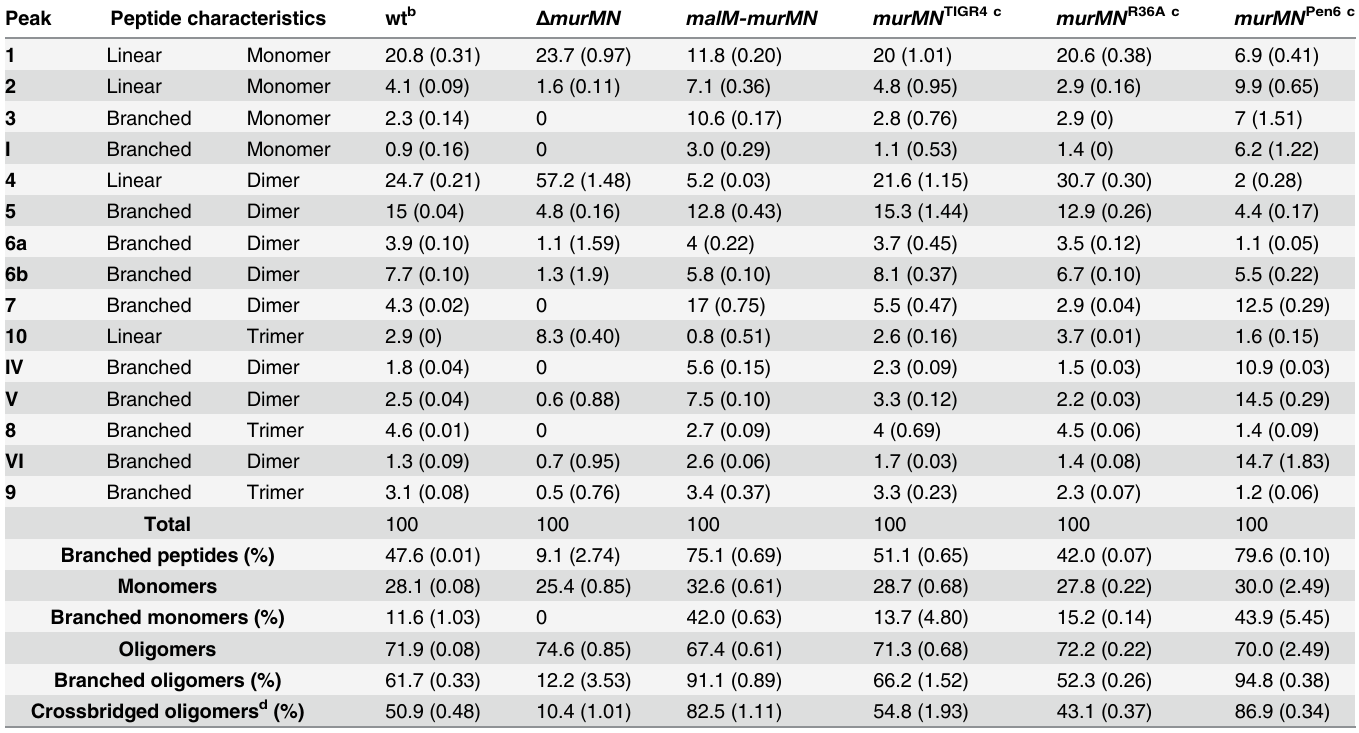
Table 1. Stem peptide composition of select S . pneumoniae strains.